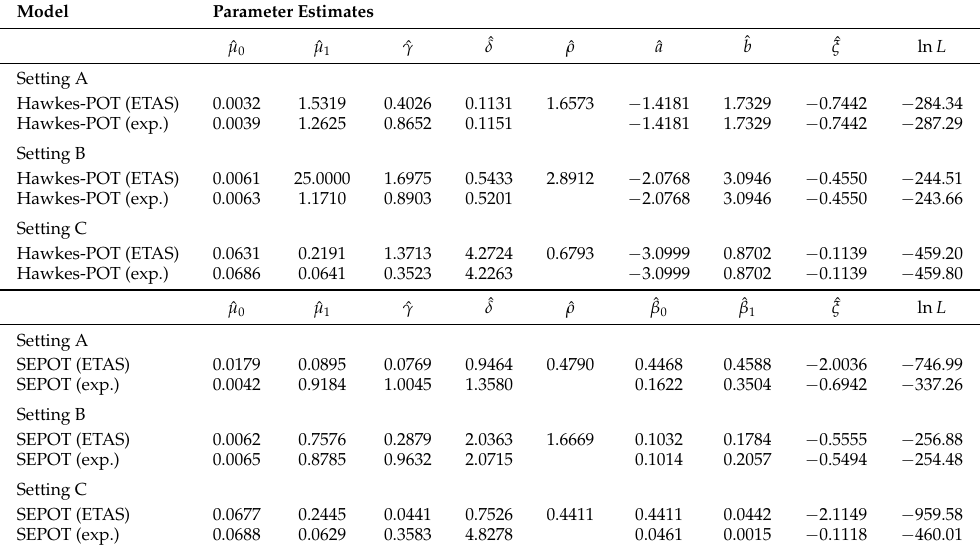
Table 3. Estimation results of the Hawkes-POT and SEPOT model for the simulated settings A, B and C. Italic numbers represent bounds of the estimation